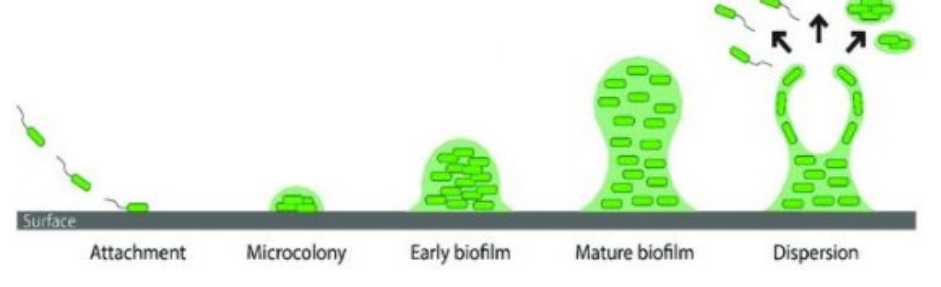
Figure 13. Stages of biofilm formation [82].